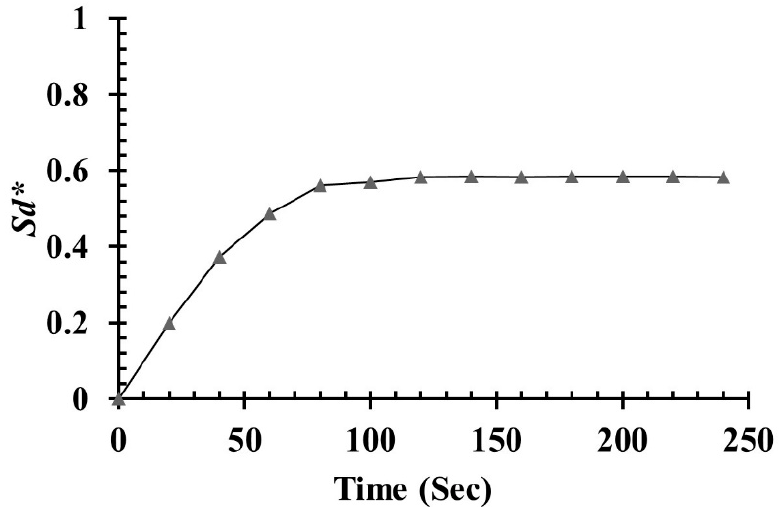
Figure 3. Time progress of dimensionless maximum scour depth ( S d * ) at the initial stage to set the equilibrium state.